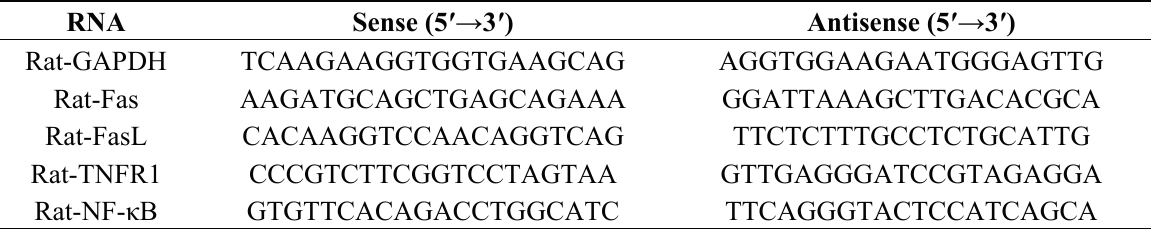
Table 1. Primers used in real-time PCR